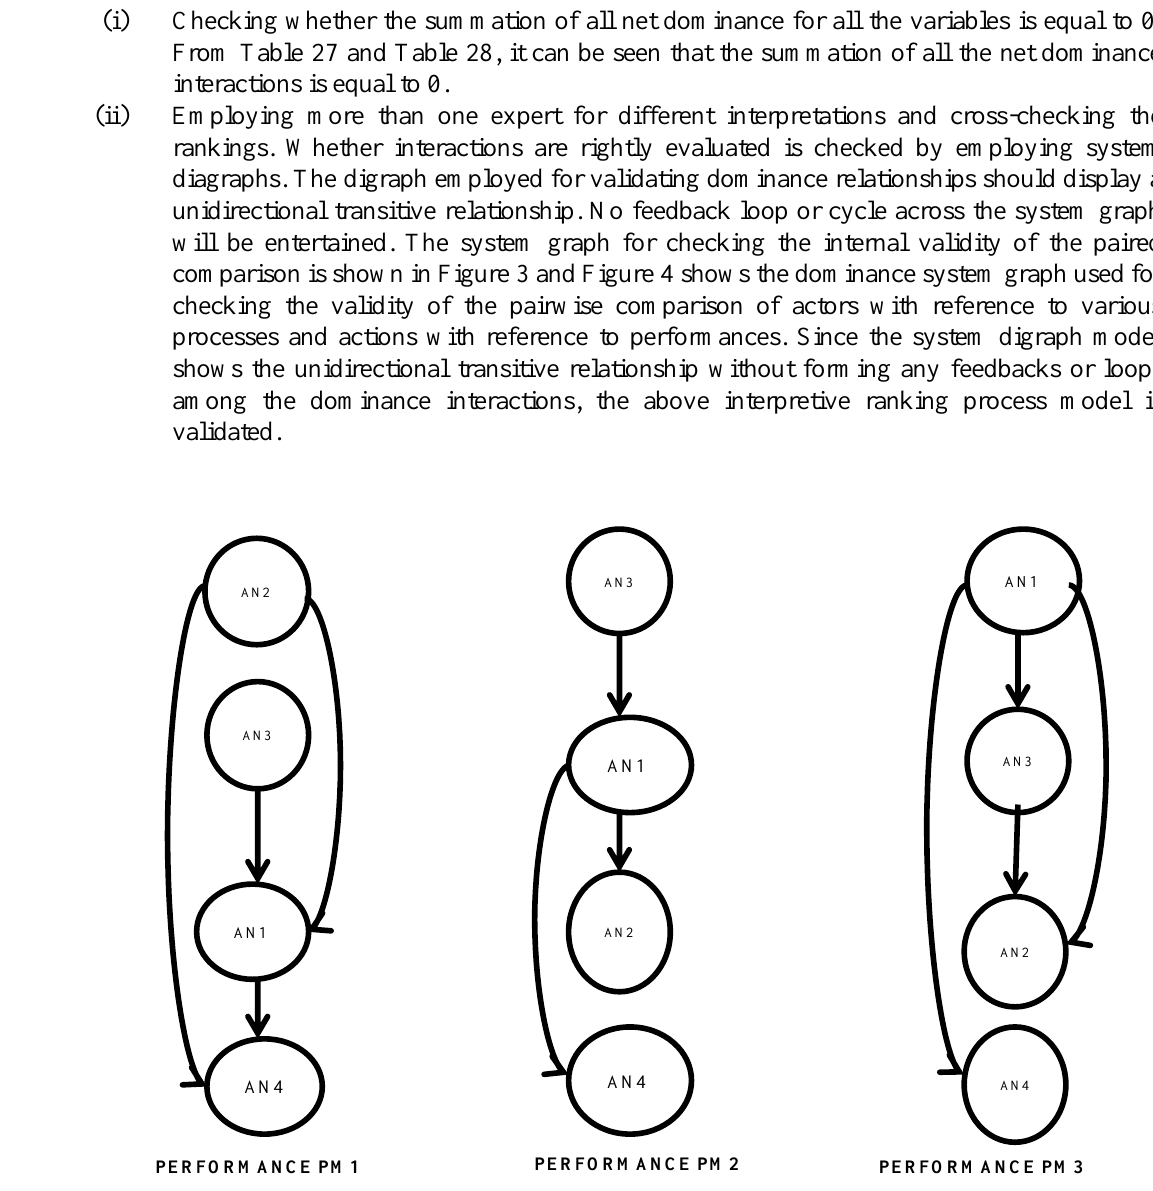
Figure 3. Dominance system graph to check the validity of pair wise comparison of actors with reference to various process